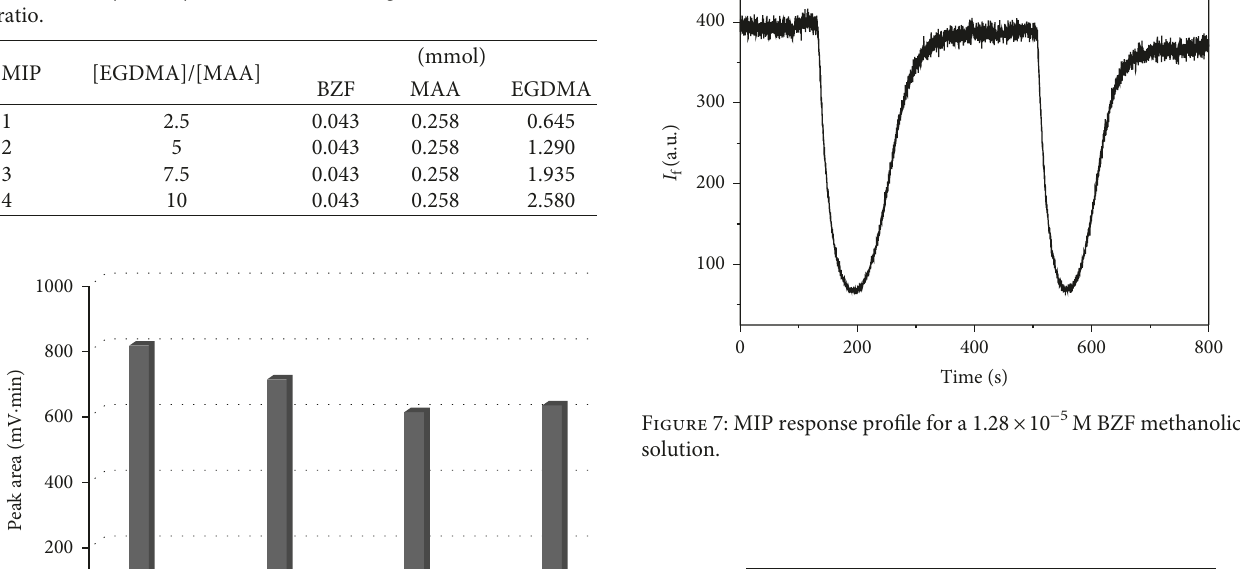
Figure 7: MIP response profile for a 1.28 solution.